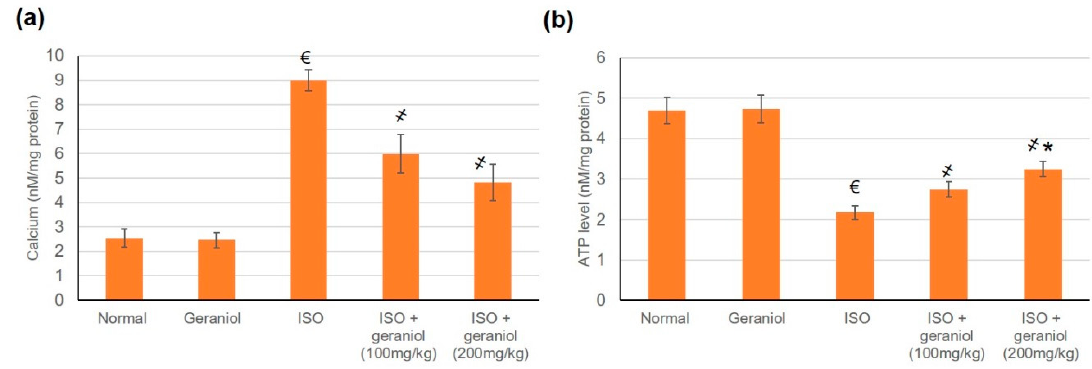
Table 2. The impact of geraniol pretreatment on ECG components in isoproterenol-induced myocardial infarction. Figure 9. Levels of mitochondrial Ca 2 + ( a ) and ATP ( b ) in isoproterenol (ISO)-induced myocardial Figure 9. Levels of mitochondrial Ca 2+ ( a ) and ATP ( b ) in isoproterenol (ISO)-induced myocardial infraction (MI) and e ff ects of geraniol pretreatment. All values were stated as mean ± SD ( n = 6). infraction (MI) and effects of geraniol pretreatment. All values were stated as mean ± SD ( n = 6). €, p € , p < 0.05 compared to the normal group; < 0.05 compared to the normal group; ҂ , p < 0.05 compared to the ISO-induced MI group; *, p < 0.05 compared to the ISO + geraniol (100 mg/kg) group. Comparisons done using one-way ANOVA followed by Tukey-Kramer post-hoc test.